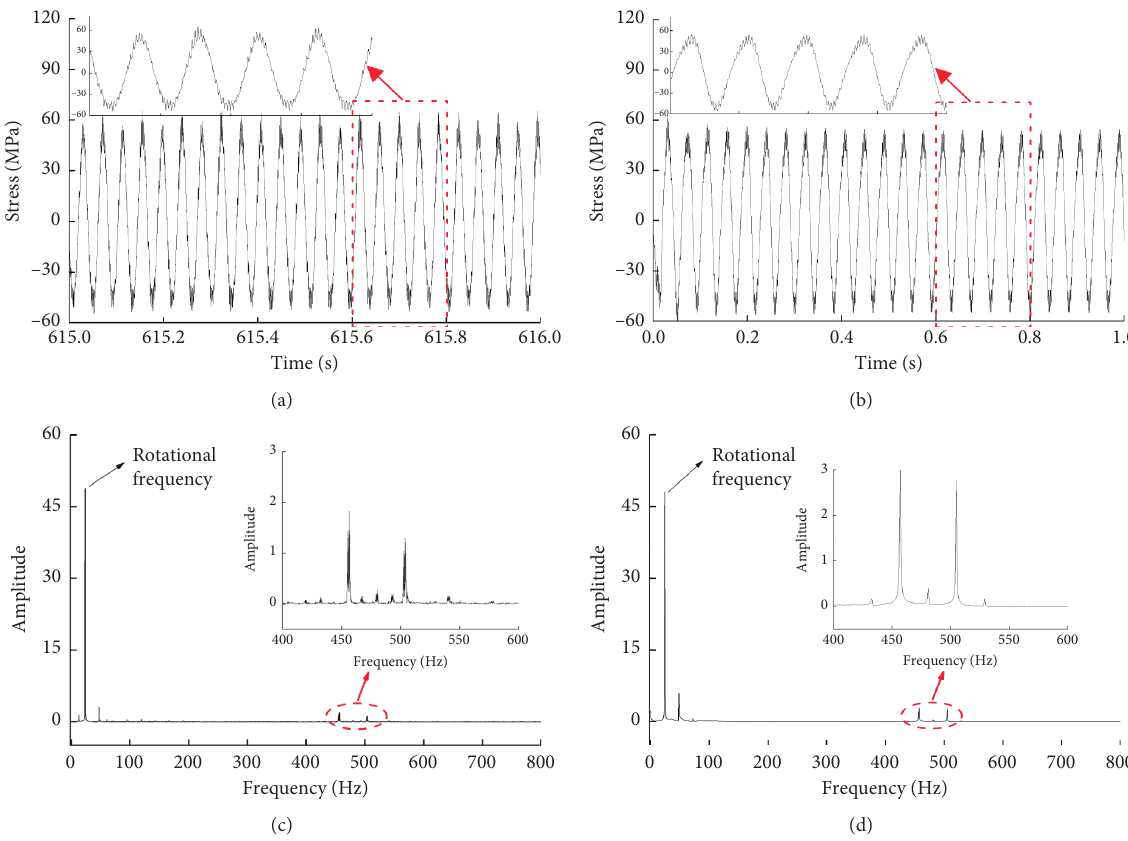
Figure 10: Comparison of the test and the simulation result. (a) Time domain result of the test, (b) time domain result of the simulation, (c) spectrum analysis result of the test, and (d) spectrum analysis result of the simulation.